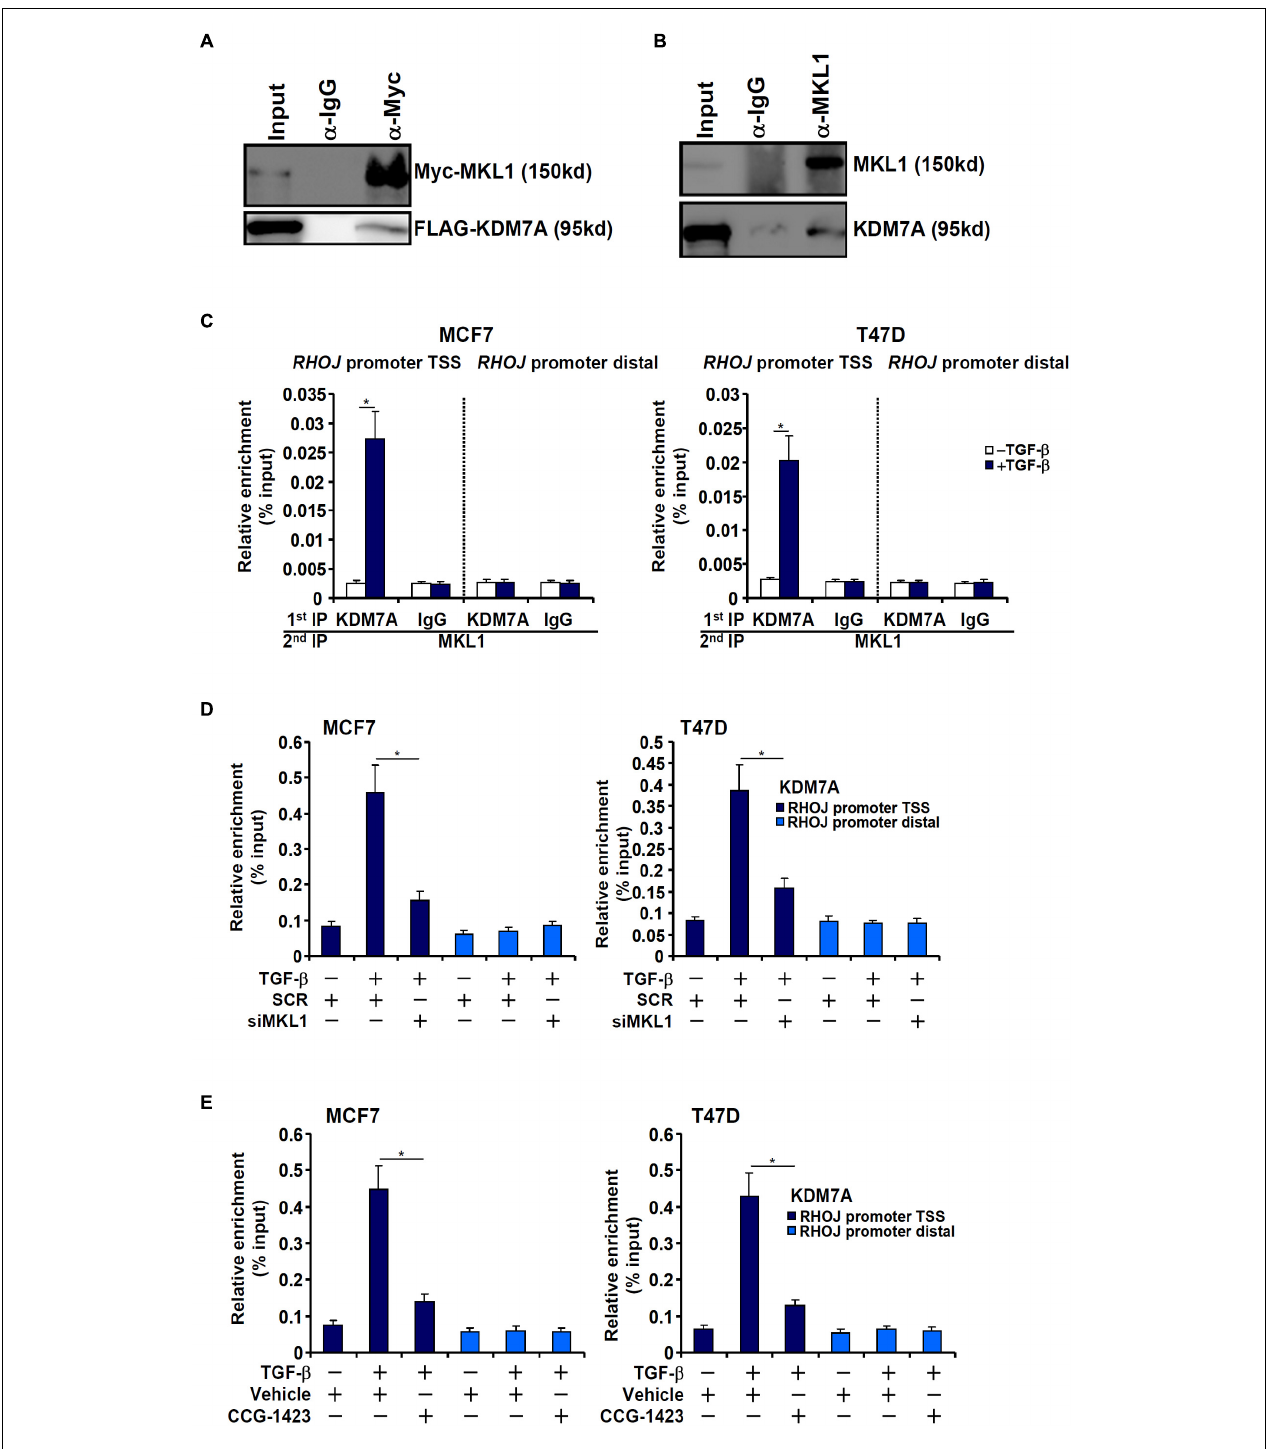
FIGURE 4 | MKL1 recruits JHDM1D/KDM7A to the RHOJ promoter. (A) FLAG-tagged KDM7A and Myc-tagged MKL1 were transfected into HEK293 cells. Immunoprecipitation was performed with anti-Myc or IgG. (B) MCF7 whole-cell lysates were immunoprecipitated with anti-MKL1 or IgG. (C) MCF7 (left panel) and T47D cells (left panel) were treated with or without TGF- β for 48 h. Re-ChIP was performed with indicated antibodies. (D) MCF7 (left panel) and T47D cells (left panel) were transfected with indicated siRNAs followed by treatment with TGF- β for 48 h. ChIP assay was performed with anti-KDM7A. (E) MCF7 (left panel) and T47D cells (left panel) were treated with TGF- β in the presence or absence of CCG-1423 (10 µ M) for 48 h. ChIP assay was performed with anti-KDM7A. All experiments were performed in triplicate wells and repeated three times, and one representative experiment is shown. Data represent mean ± SD. * p < 0.05, two-tailed t -test. MKL1 interacted with KDM7A and depletion/inhibition of MKL1 reduced KDM7A recruitment to the RHOJ promoter.